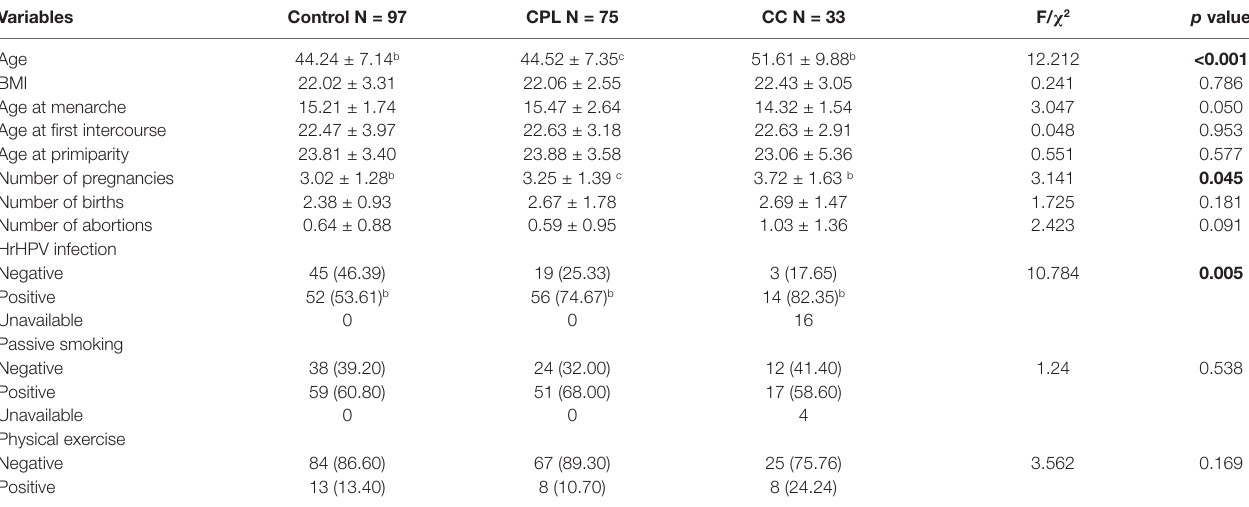
TABLe 1 | Demographic characteristics in control, CPL, and